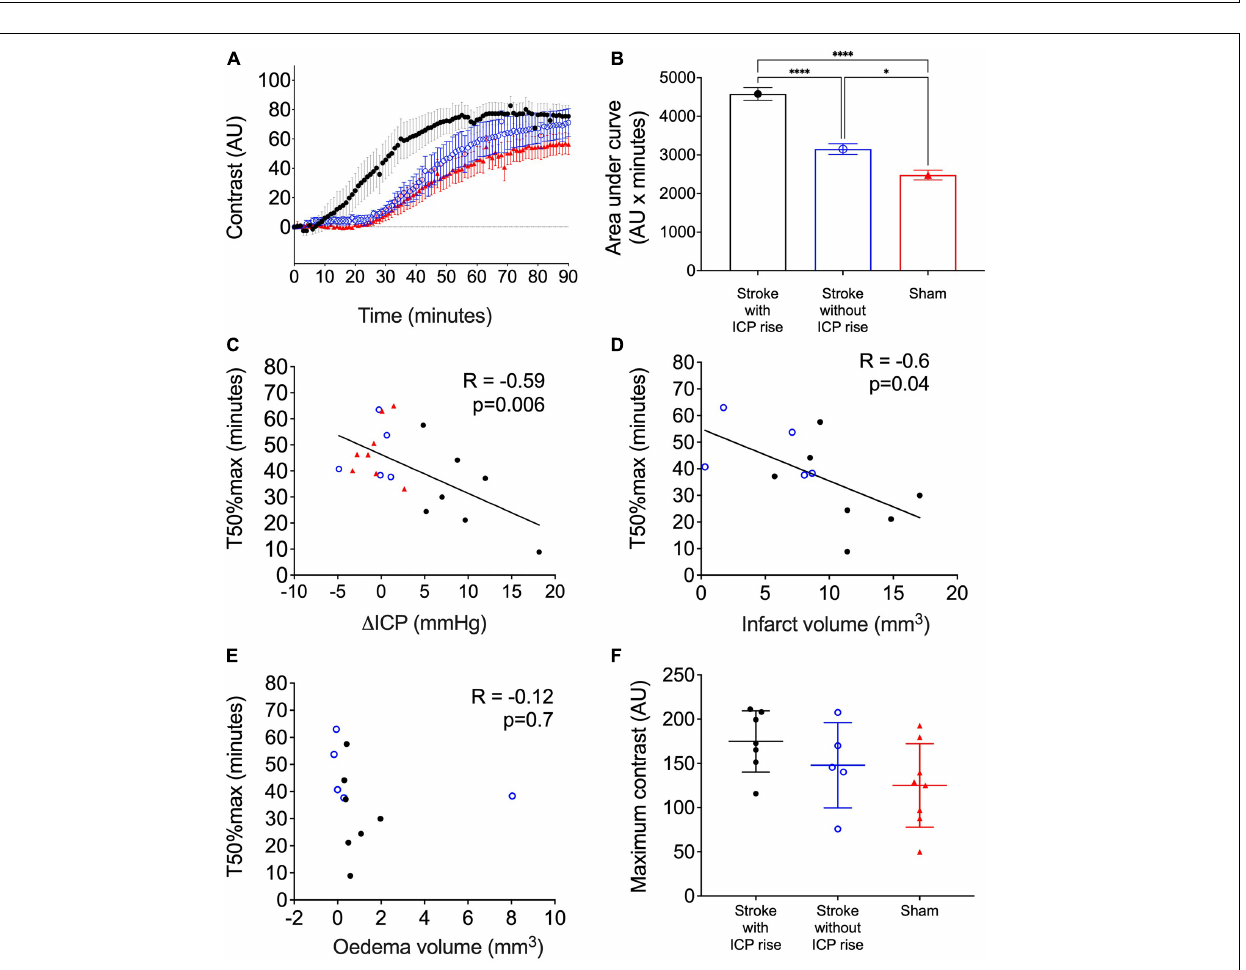
FIGURE 5 | (A) Average contrast development (arbitary units; AU) over time (minutes) for stroke rats with intracranial pressure (ICP) rise greater than +4.4 mmHg (black closed circles), stroke rats with no ICP rise (blue open circles), and sham rats (red triangles). Presented as mean ± standard error of the mean (SEM). (B) Area under the curve (AU × minutes) presented for each group as mean ± SEM, ANOVA with post hoc Bonferroni test. (C) Relationship between (cid:49) ICP (mmHg) and time to reach 50% maximum contrast (T50%max; minutes). A Spearman correlation was used to determine the relationship. (D) Relationship between infarct volume (mm 3 ) and T50%max, Pearson correlation. (E) Relationship between oedema volume (mm 3 ) and T50%max, Pearson correlation. (F) Maximum contrast (AU) observed in each group, mean ± standard deviation.